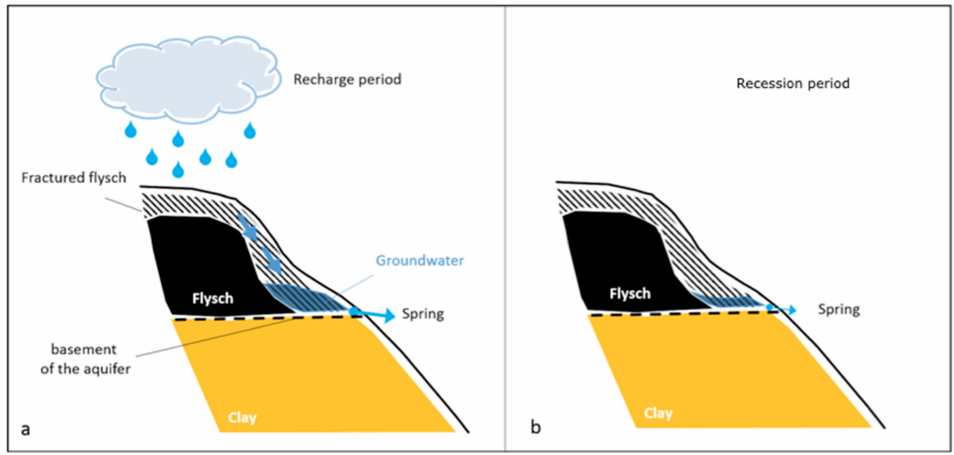
Figure 3. Simplified sketch of a low-yield spring discharging from the fractured zone of a flysch rock mass. ( a ) Recharge period (from winter to spring); ( b ) recession period (from the end of summer to the beginning of autumn). The arrows indicated by the spring are directly proportional to the